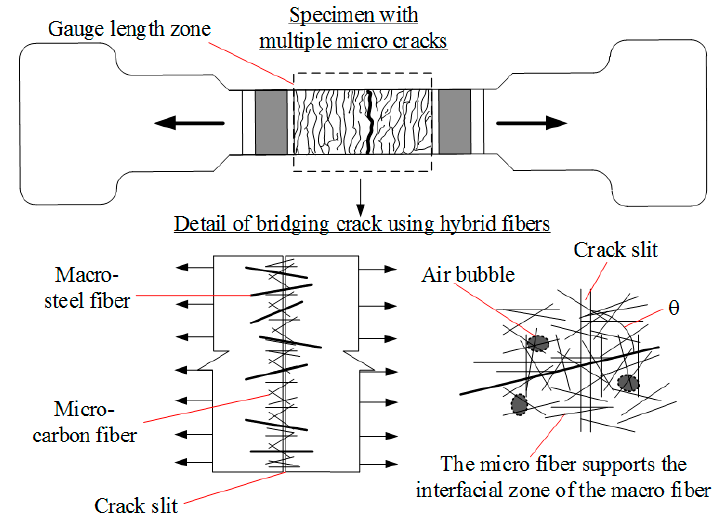
Figure 20. Mechanism of bridging crack using hybrid fibers.